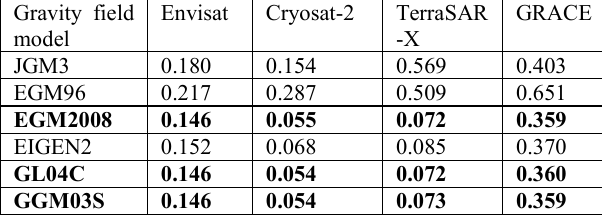
Table 4. RMS(m) in the radial direction in 120 min prediction.